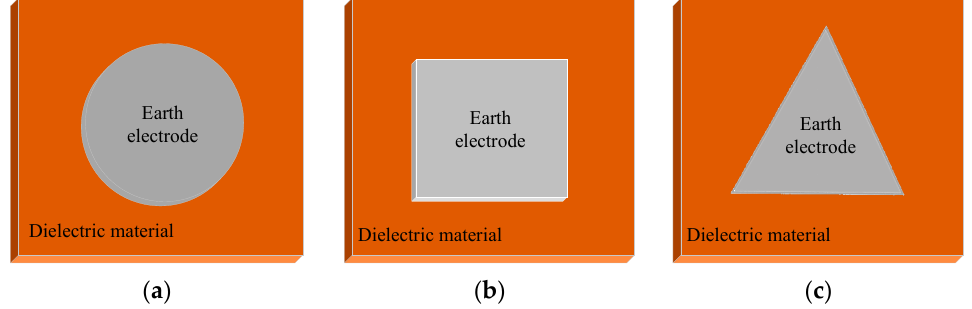
Figure 1. Setting of ground electrode for dielectric materials, ( a ) Circular electrode, ( b ) Square electrode, ( c ) Triangular electrode.